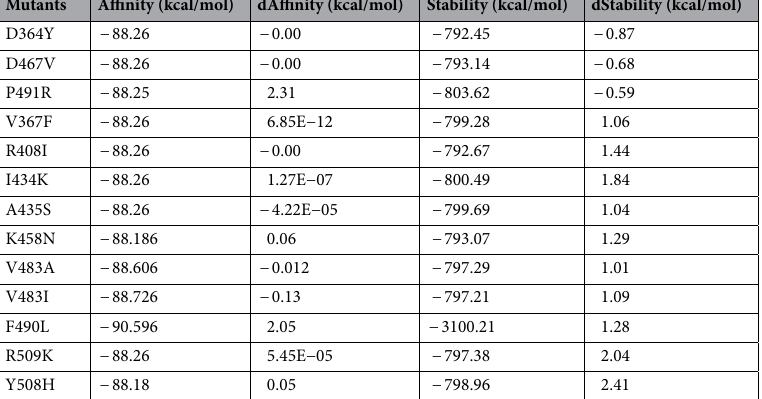
Table 4. The stability of the variants of SARS-CoV-2 spike RBD bound to human ACE2, red marks the enhanced ones while black represents the decreased ones.